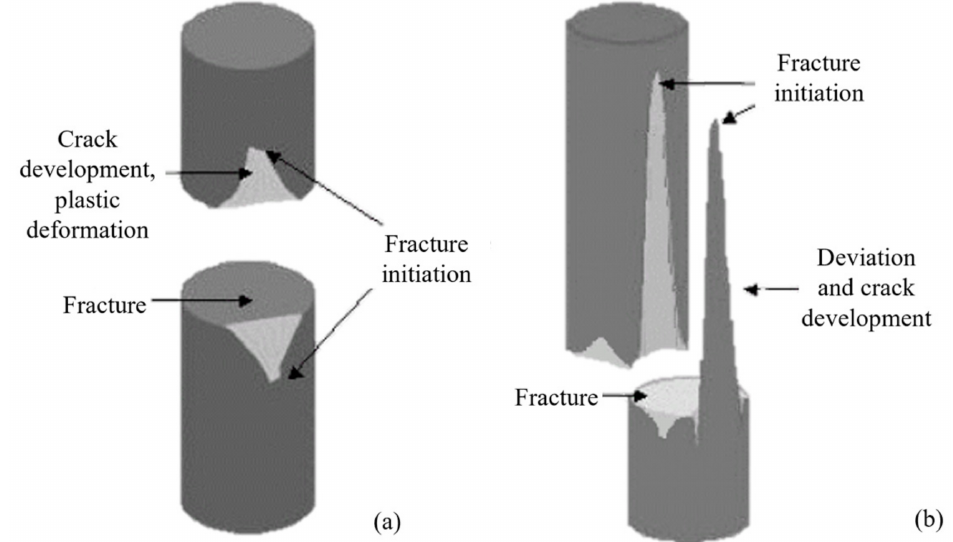
Figure 1. Fracture morphology of polyester and polyamide fibers: ( a ) due to tension; ( b ) due to fatigue